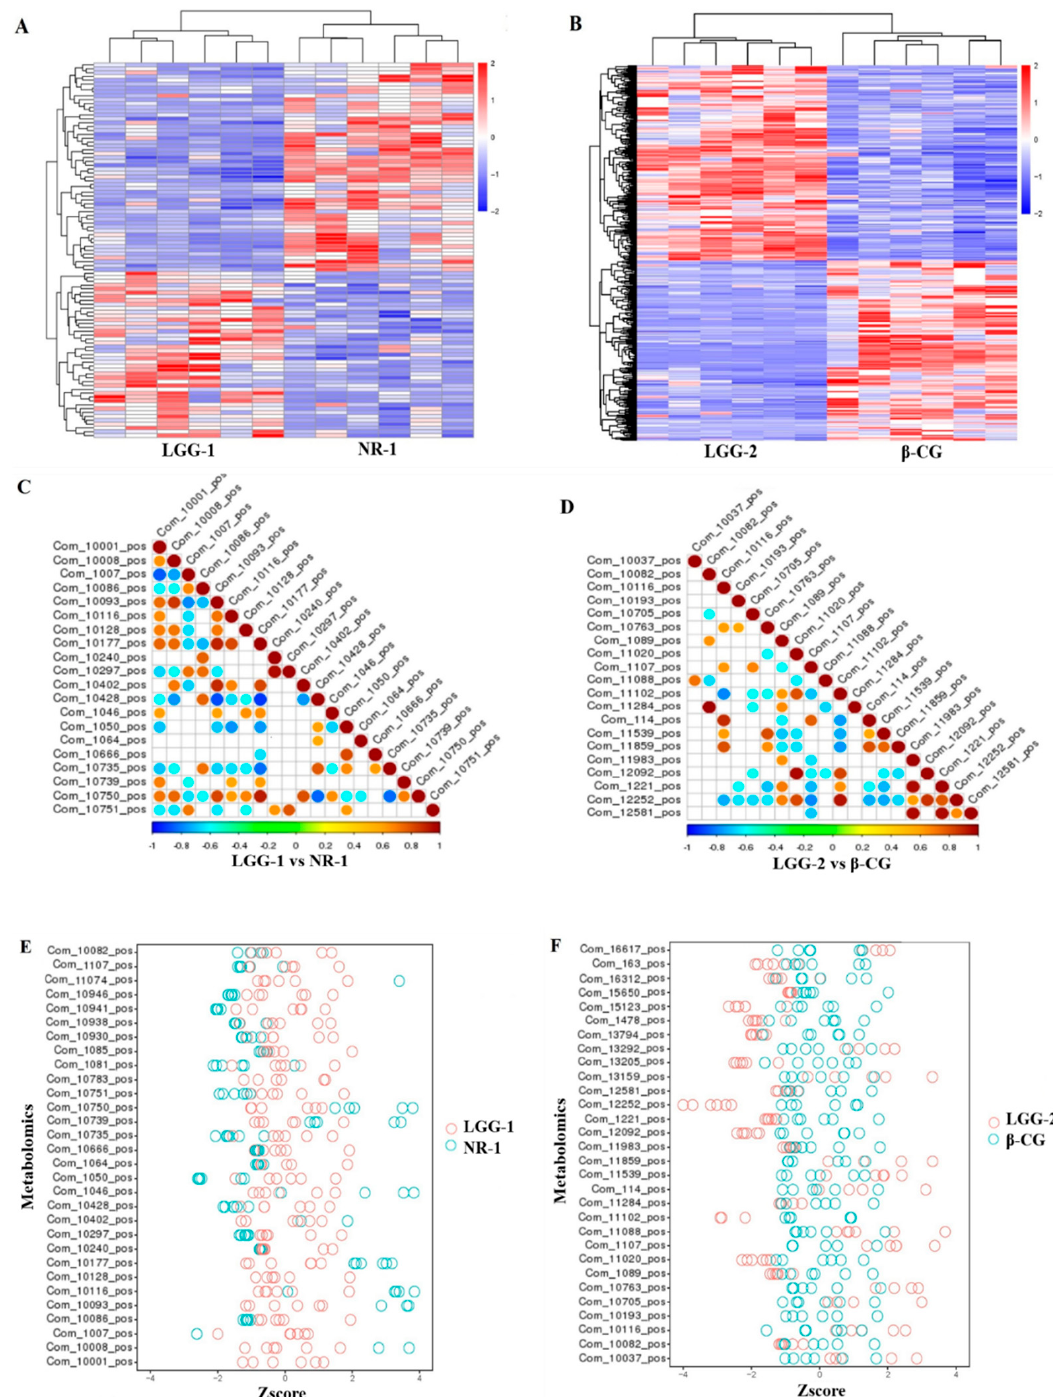
Figure 5. Analysis of differential metabolites between different groups. ( A ) Cluster heat map of differential metabolites in positive ion mode between the LGG-1 group and the NR-1 group. ( B ) Cluster heat map of differential metabolites in positive ion mode between the LGG-2 group and the β -CG group; ( C ) Correlation diagram of differential metabolites in positive ion mode between the LGG-1 group and the NR-1 group; ( D ) Correlation diagram of differential metabolites in positive ion mode between the LGG-2 group and the β -CG group; ( E ) Z-score chart in positive ion mode between the LGG-1 group and the NR-1 group; ( F ) Z-score chart in positive ion mode between the LGG-2 group and the β -CG group.